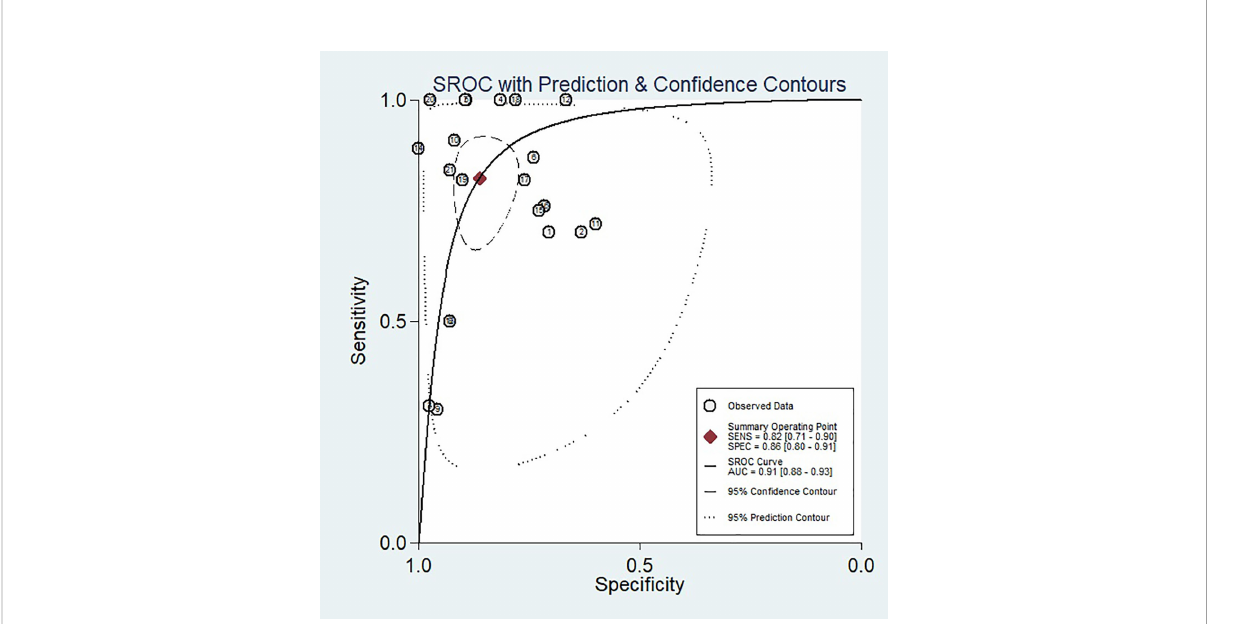
FIGURE 5 SROC curve of the diagnostic performance of arti fi cial intelligence for the prediction of pathological complete response to neoadjuvant chemoradiotherapy in rectal cancer patients. An obvious difference was detected between the 95% CI and 95% prediction regions, indicating a high possibility of heterogeneity across the